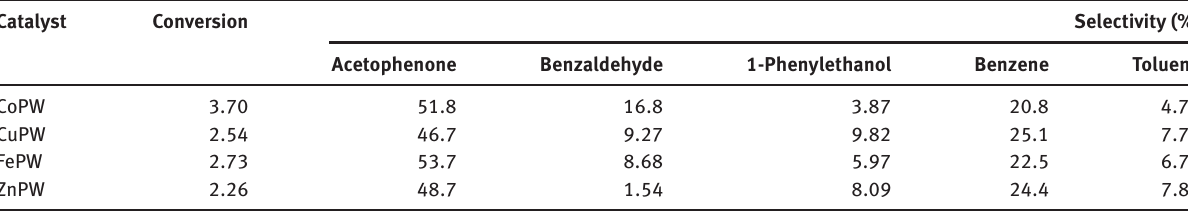
Table 2: Effect of heteropolyoxometalate cation on ethylbenzene oxidation. Catalyst